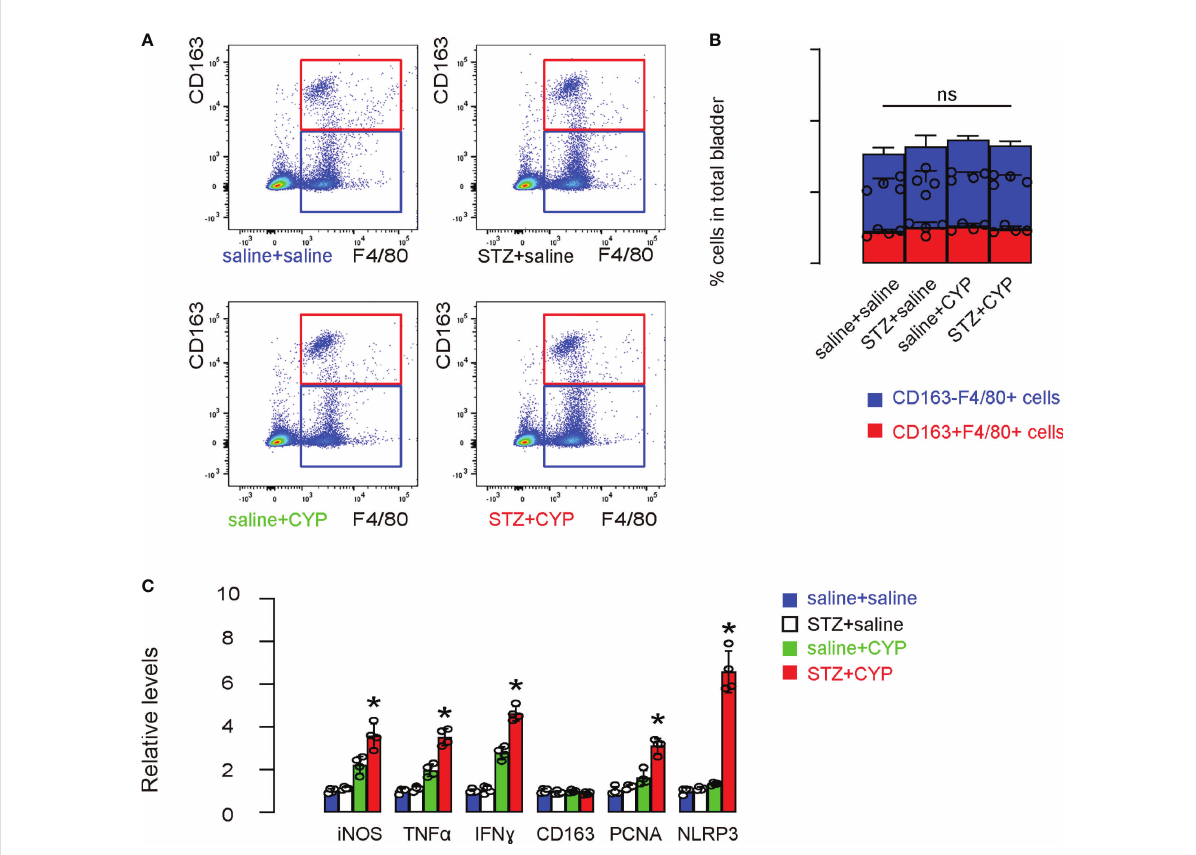
FIGURE 3 NLRP3 signi fi cantly increases in bladder macrophages in diabetic mice that undergo cystitis. (A, B) Mouse bladders were sorted for bladder macrophages based on positivity for F4/80, and further for M1 (CD163-) and M2 (CD163+) subtypes among all F4/80+ macrophages, shown by representative fl ow charts (A) and by quanti fi cation (B) . (C) ELISA for some critical factors for macrophage phenotype and functionality. *p<0.05. ns: no signi fi